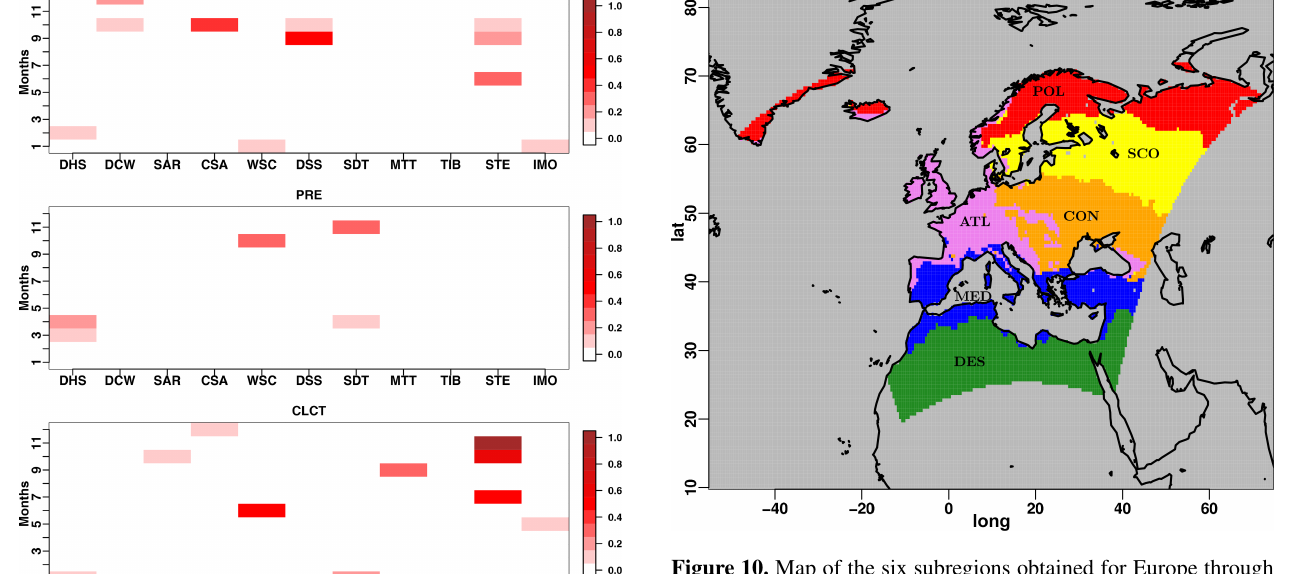
Figure 10. Map of the six subregions obtained for Europe through k -means clustering of the q -normalized monthly climatologies of the considered variables, calculated over the period of